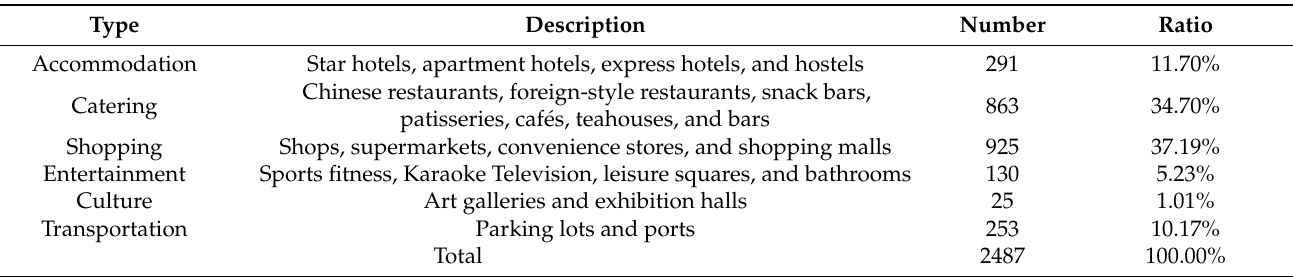
Table 1. Types and ratios of tourist service facilities.